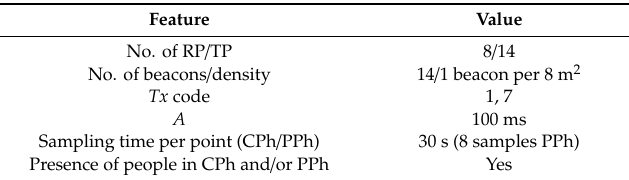
Table 28. Main features of Tests #11.